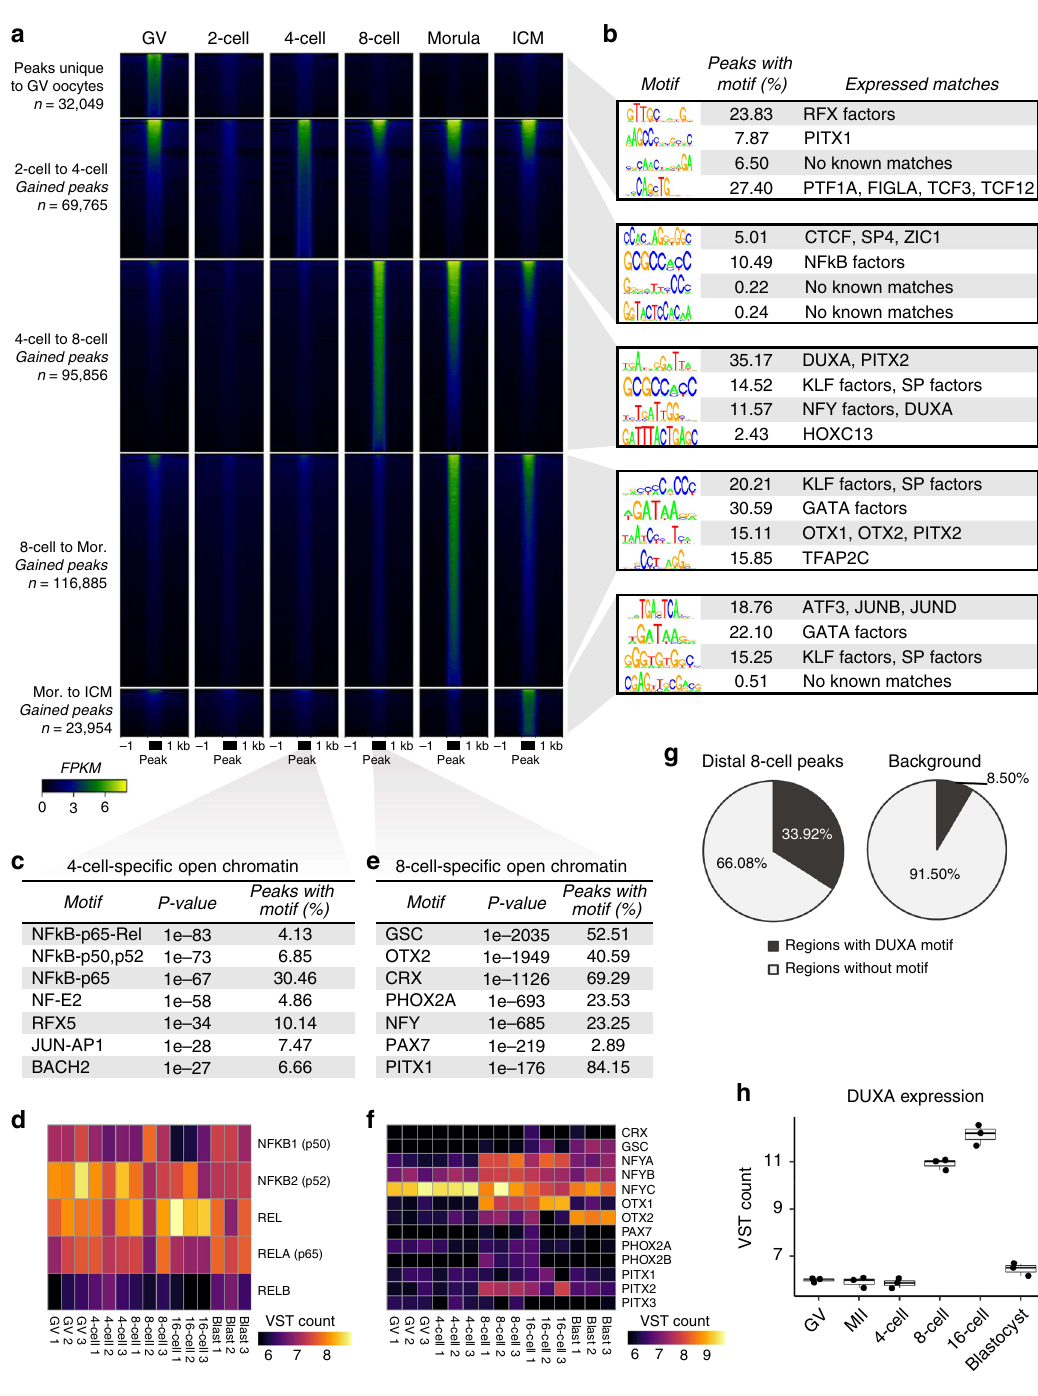
Fig. 2 Gradual establishment of open chromatin enriched in regulatory motifs. a Normalized ATAC-seq signal (FPKM) shown at peaks that were either unique to GV oocytes, or which were gained between consecutive developmental stages. Peaks at each stage were called from 30 million reads, and were scaled to 500 bp. b Top four de novo motifs enriched in intergenic peaks, matched to known motifs (log odds match score >0.6) of TFs that were expressed at the given stage. c Top seven known motifs enriched in 4-cell speci fi c peaks. Binomial test p values reported. Adjustment for false discovery rate (FDR) yielded Q values less than 1e – 4. d Variance stabilized transformed (VST) expression counts of TFs corresponding to enriched motifs in 4-cell speci fi c open chromatin. e Top seven known motifs enriched in 8-cell speci fi c peaks. Binomial test p values reported (all FDR adjusted Q values <1e – 4). f VST expression counts of TFs corresponding to enriched motifs in 8-cell speci fi c open chromatin. g Proportion of intergenic 8-cell peaks overlapping the de novo motif most closely matching the DUXA motif, relative to background. h VST expression counts of DUXA throughout development ( n = 3 biologically independent samples). Boxplots indicate the median and interquartile range (IQR), and whiskers span 1.5 times the IQR. RNA-seq data from Graf et al. 32 . Source data are provided as a Source Data fi